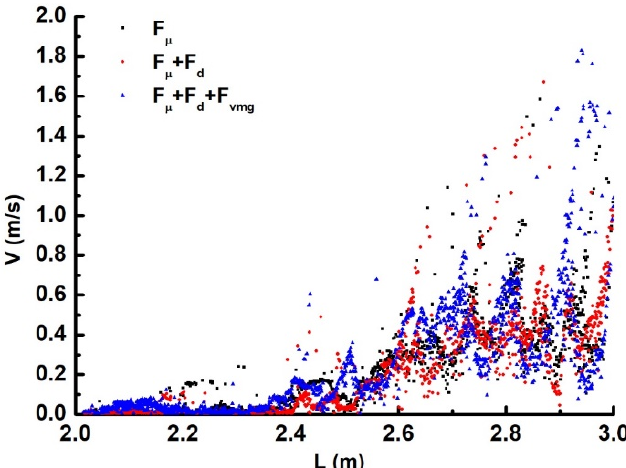
Figure 9. Particles velocity distribution within different initiation modes.